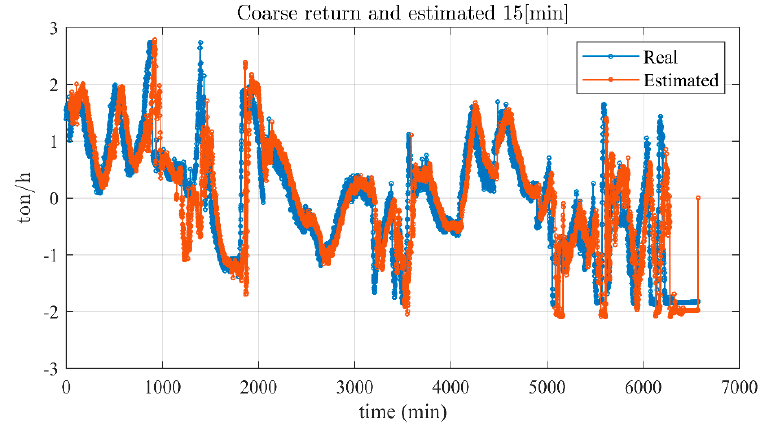
Figure 9. Actual coarse return and those predicted for 15 min ahead in the test dataset.